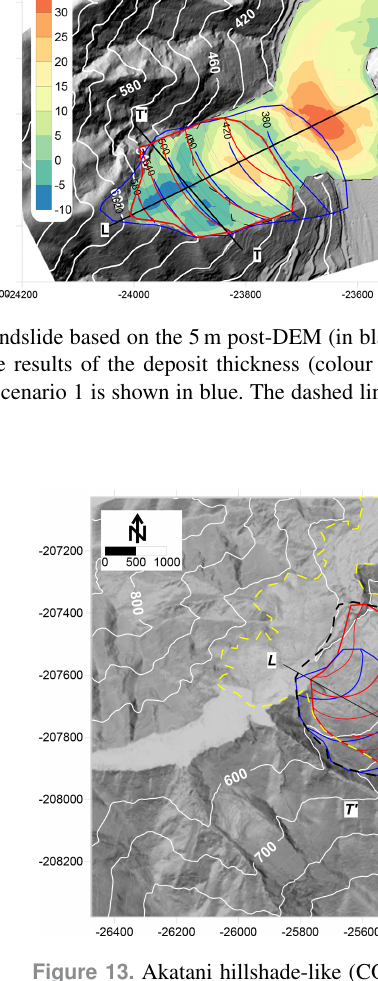
Figure 13. Akatani hillshade-like (COLTOP scheme in black and white) map from the 1m post-DEM, displaying the limits of the landslide scenarios and failure surface topography. Scenario 1: largest scenario (black dashed line). Scenario 2: the most likely based on the pre-DEM interpretation (blue line); mixed scenario in red. The yellow dashed line is the limit of scar and deposit. The cross sections are shown by L − L (cid:48) , T − T (cid:48) , and U − U (cid:48) . ing for the missing deposit ((11 . 73 + 0 . 89) × 10 6 m 3 ) gives 12 . 62 × 10 6 m 3 with an expansion coefficient of 12.6 %, and if the volume of the spur is removed, the expansion